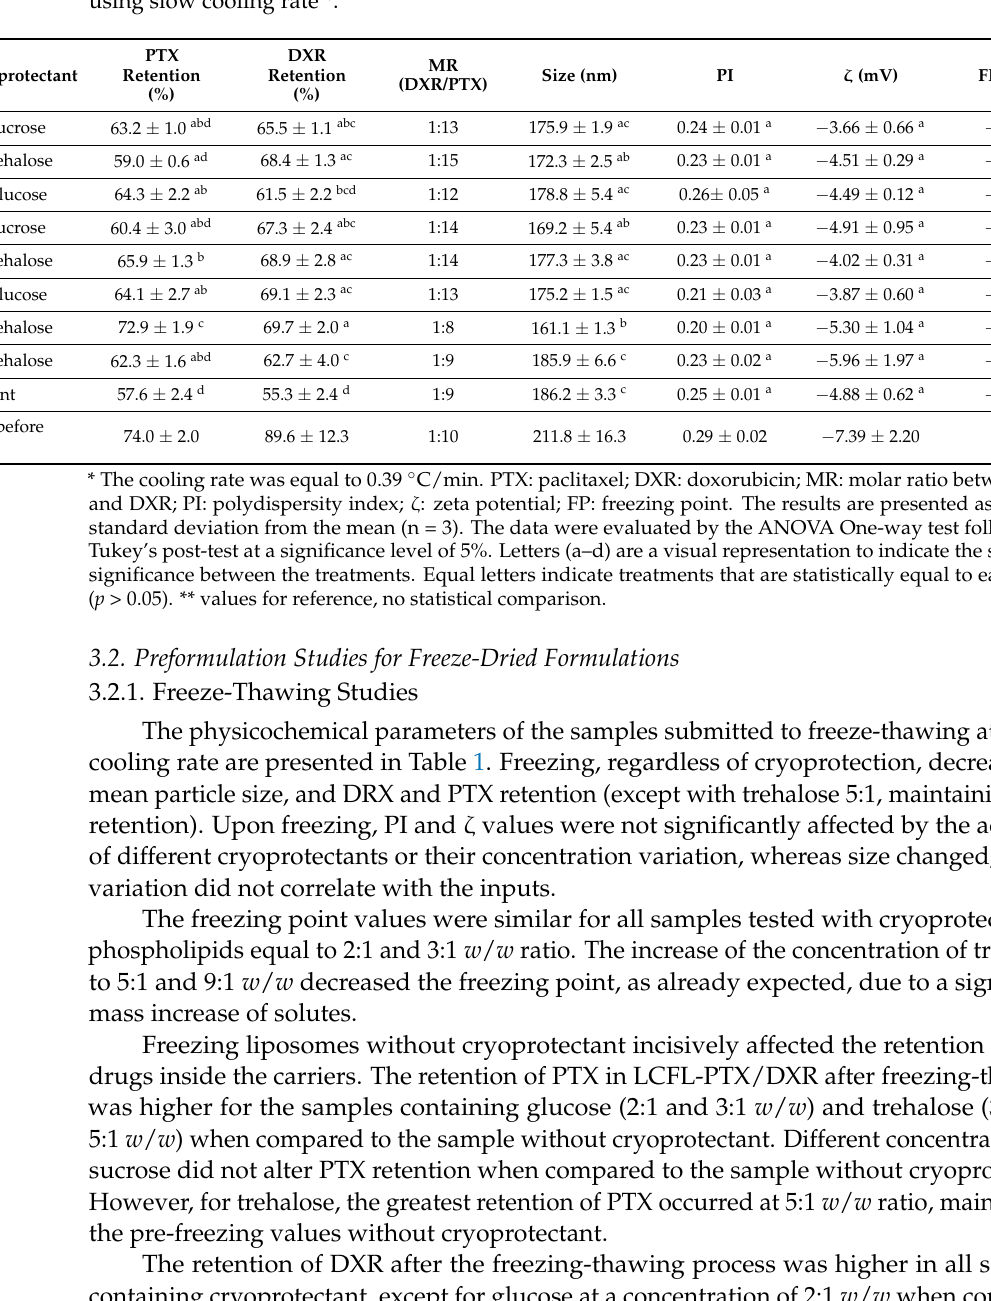
Table 1. Chemical and physicochemical characterization of LCFL-PTX/DXR after freeze-thawing using slow cooling rate